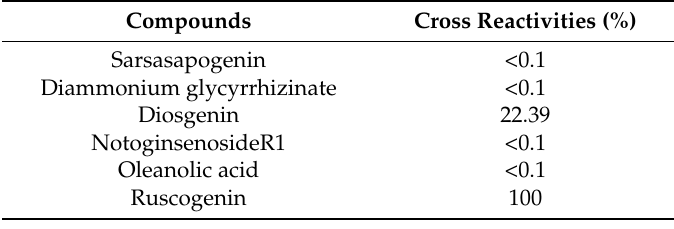
Table 2. Cross reactivities of mAb against various compounds directed by FLISA.